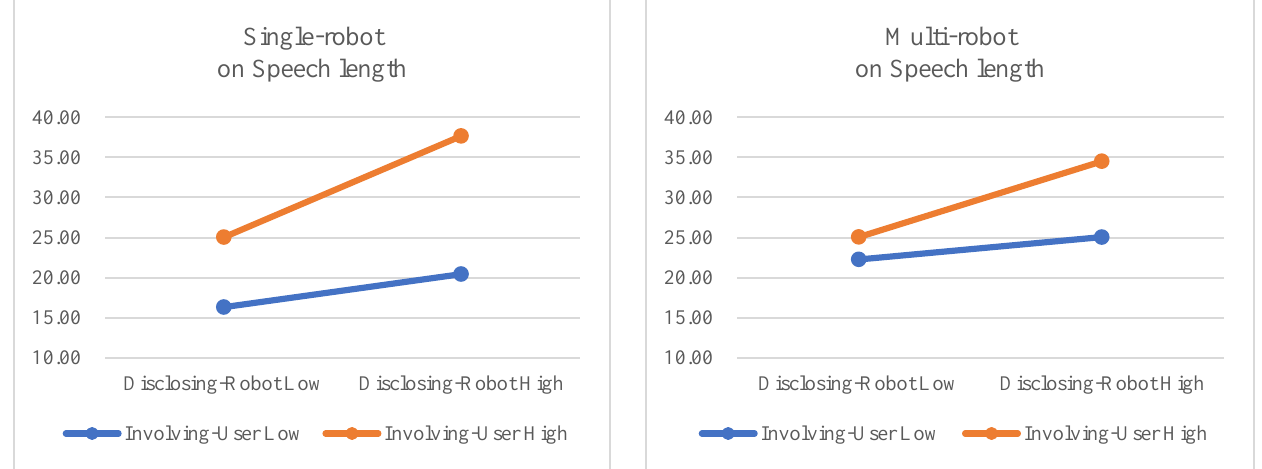
Figure 6. Moderation effects of multi-robot on speech length.